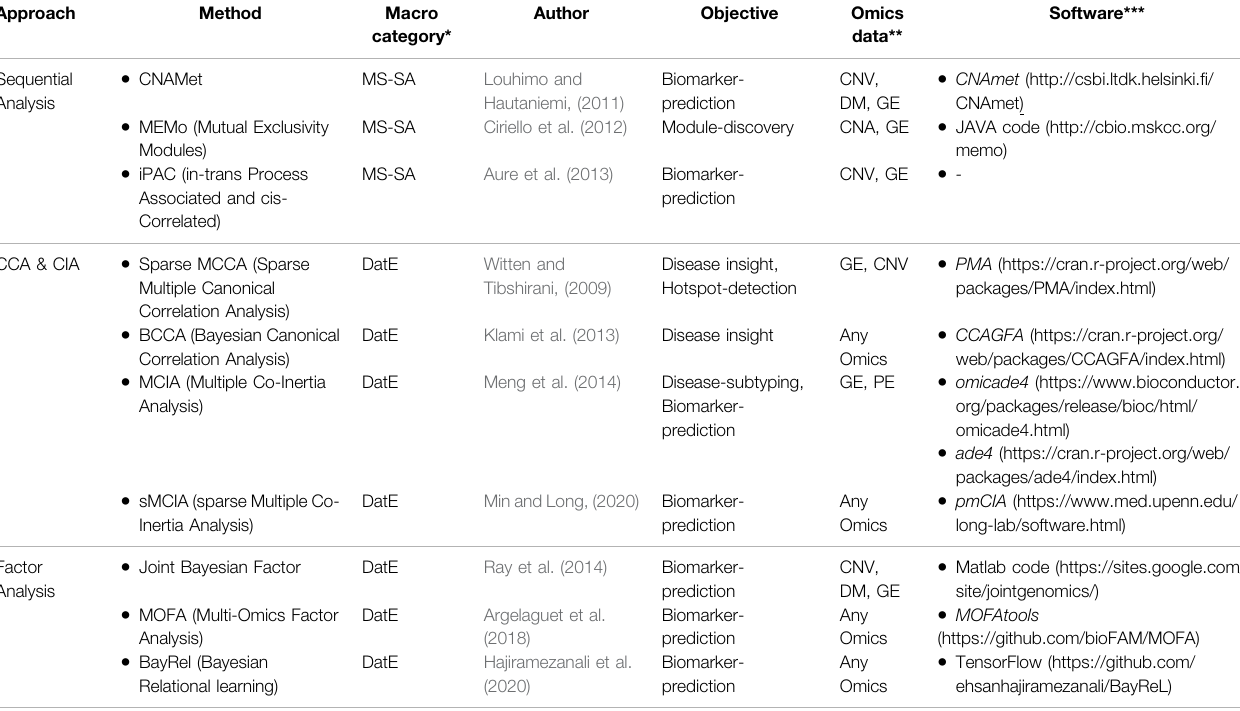
TABLE 2 | Low-level: Regression/Association-based unsupervised integration methods.